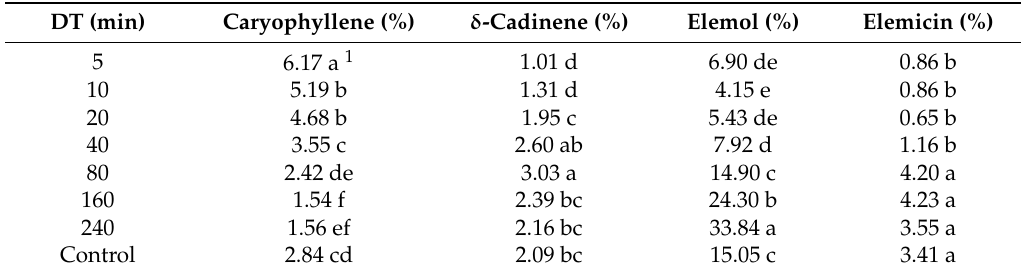
Table 2. Mean Juniperus virginiana concentrations (%) of caryophyllene, δ -cadinene, elemol, and elemicin in the essential oil fractions obtained from the 8 distillation times (DT).